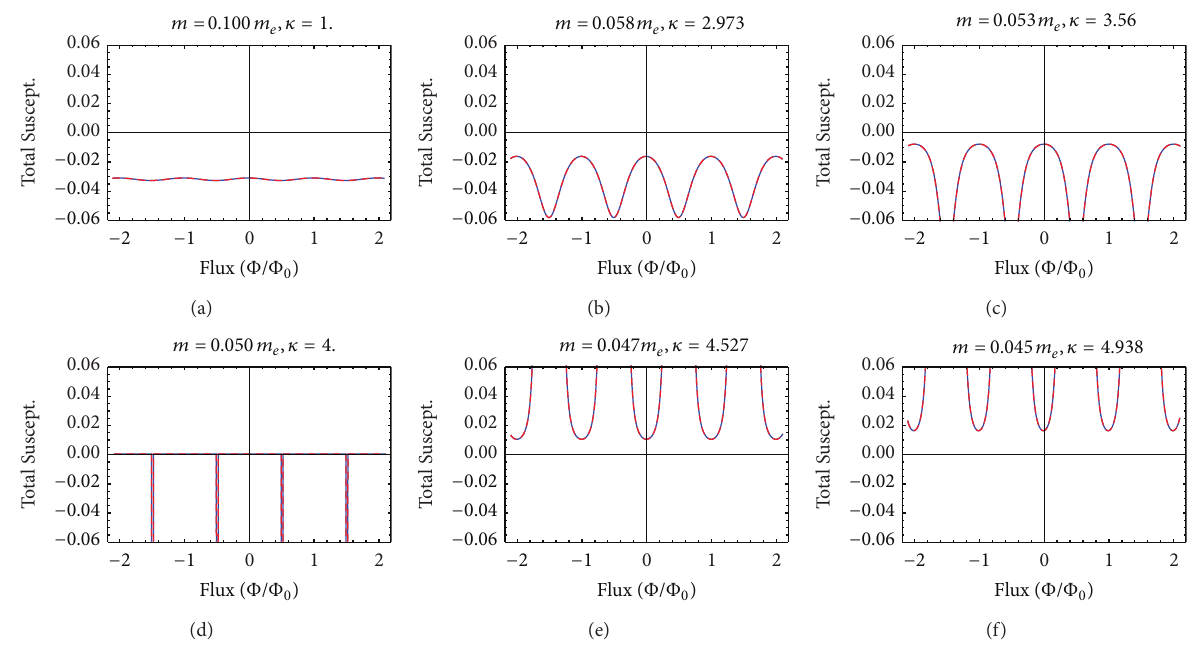
Figure 7: Nature of susceptibility for a ring with radius 𝑅 = 10𝑟 𝑒 at different masses which are written on the top of every plot. We have used the same units as Figure 2 in which the unit of susceptibility is Ω 𝑒 = 𝑒𝐼 𝑒 /𝑟 𝑒 𝐸 𝑒 . For large mass, susceptibility is negative (a) and almost constant. It shows periodic oscillation with a negative amplitude ((b) and (c)) for 𝑚 > 𝑚 mass, it again shows oscillation ((e) and (f)) but with positive amplitude. The blue and red dashed lines correspond to even and odd number of electrons which overlaps with each other.